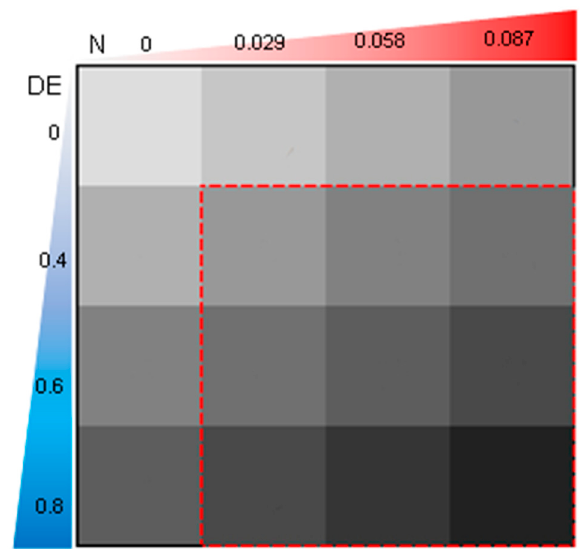
Figure 1. Experimental design of DewEco (DE) and N treatment. Red box indicates treatments with DewEco and N mixed application. Darker blue shading represents increasing dosages of DewEco, and darker red shading represents increasing dosages of N.